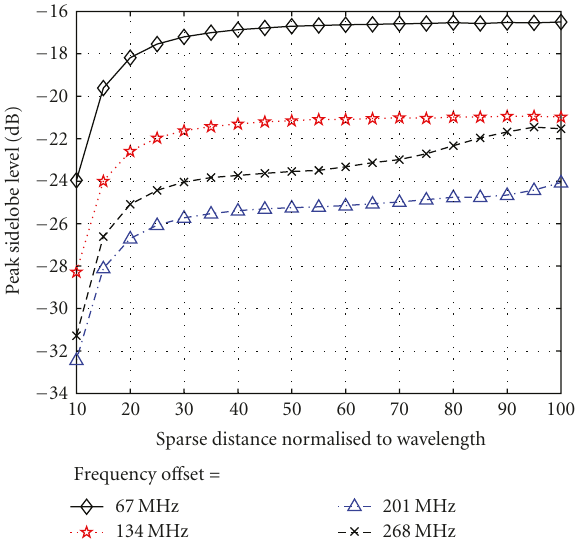
Figure 8: Beam pattern for MIMO and MIMO-FD arrays with the sparse distance L = 10 λ 0 / 2.